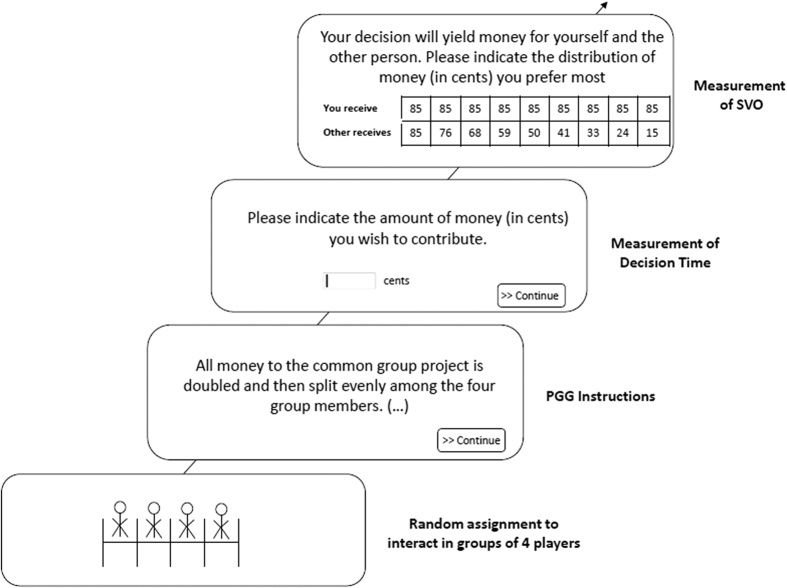
Procedure of the studies.Note: PGG refers to Public Goods Game, SVO stands for Social Value Orientation.